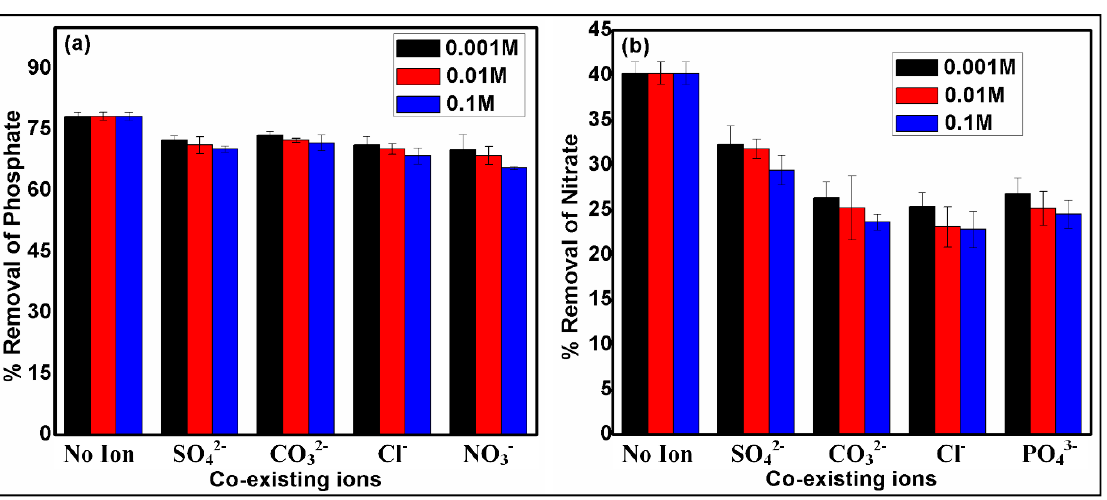
Figure 6. Effect of coexisting ions on the removal of phosphate ( a ) and nitrate ( b ) using SBAC 100 MgFe